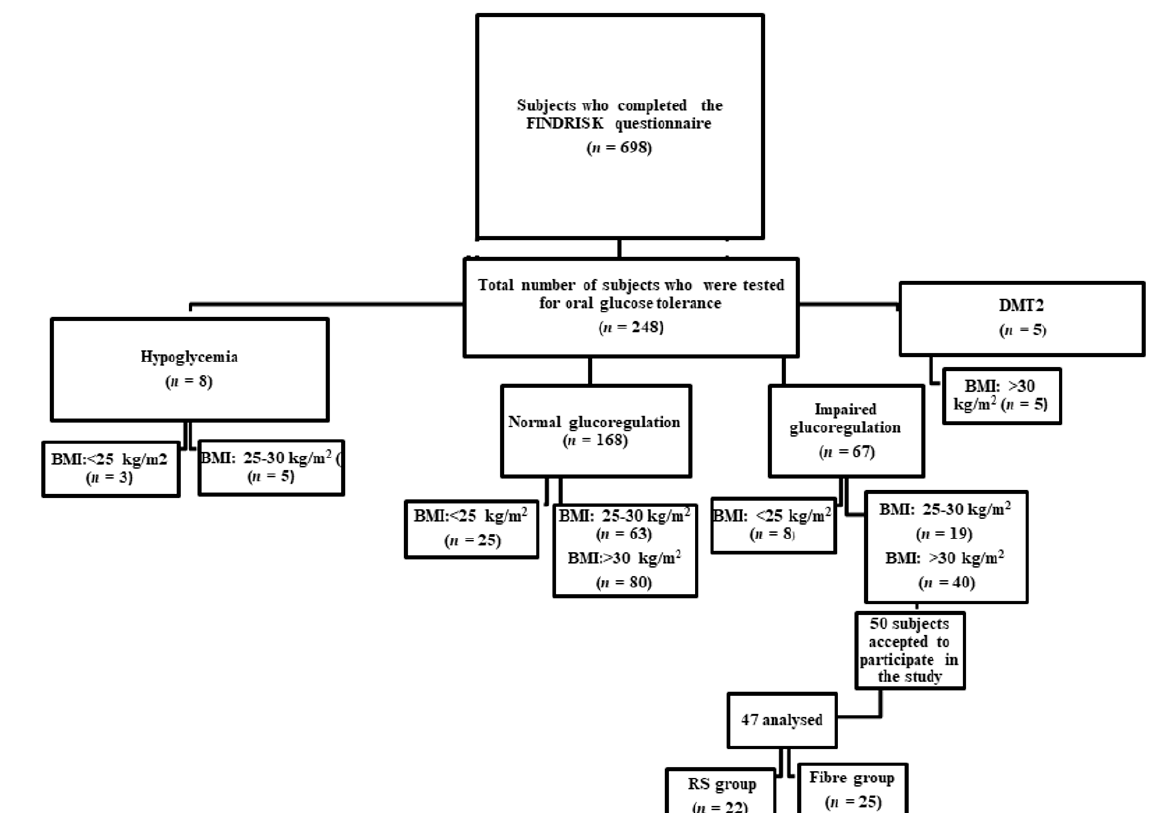
Figure 1. Flow diagram of participants recruiting. Table 1. Socio-economic and lifestyle characteristics of the sample population at the beginning of the